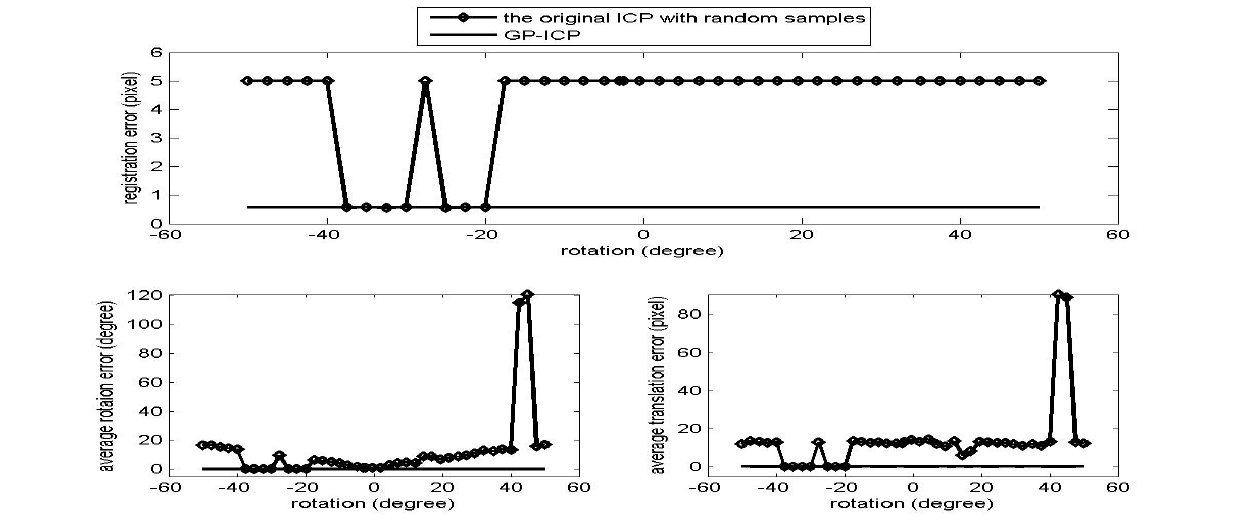
Figure 3. Convergence region test of the point clouds from the cactus with a translation, the translation 2, i.e. (-H/4, L/4, W/2).